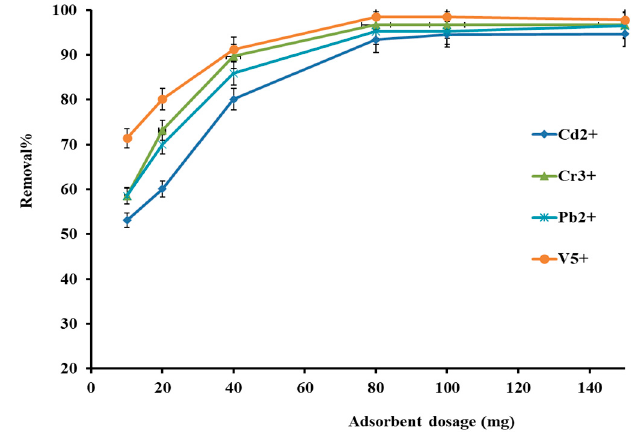
Figure 6. Effect of AC-SML dosage on metal ion removal efficiency.